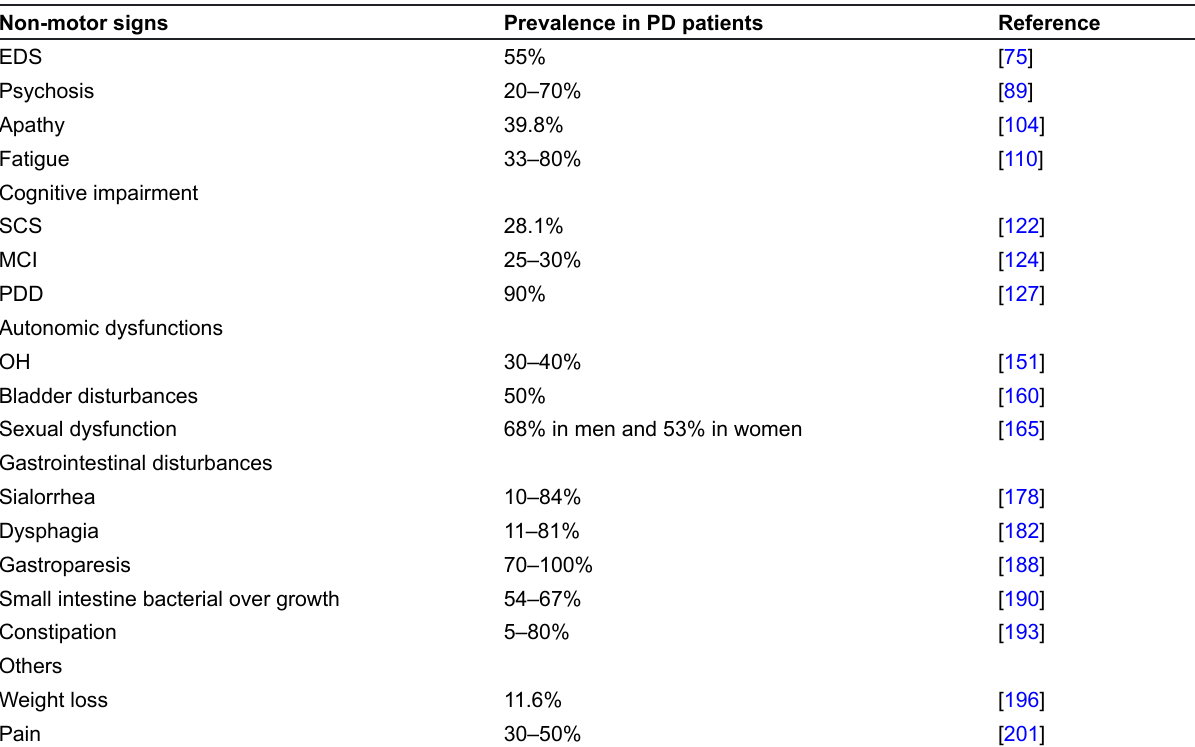
Table 1. Non-motor signs in PD and their prevalence ( continued ) Non-motor signs Prevalence in PD